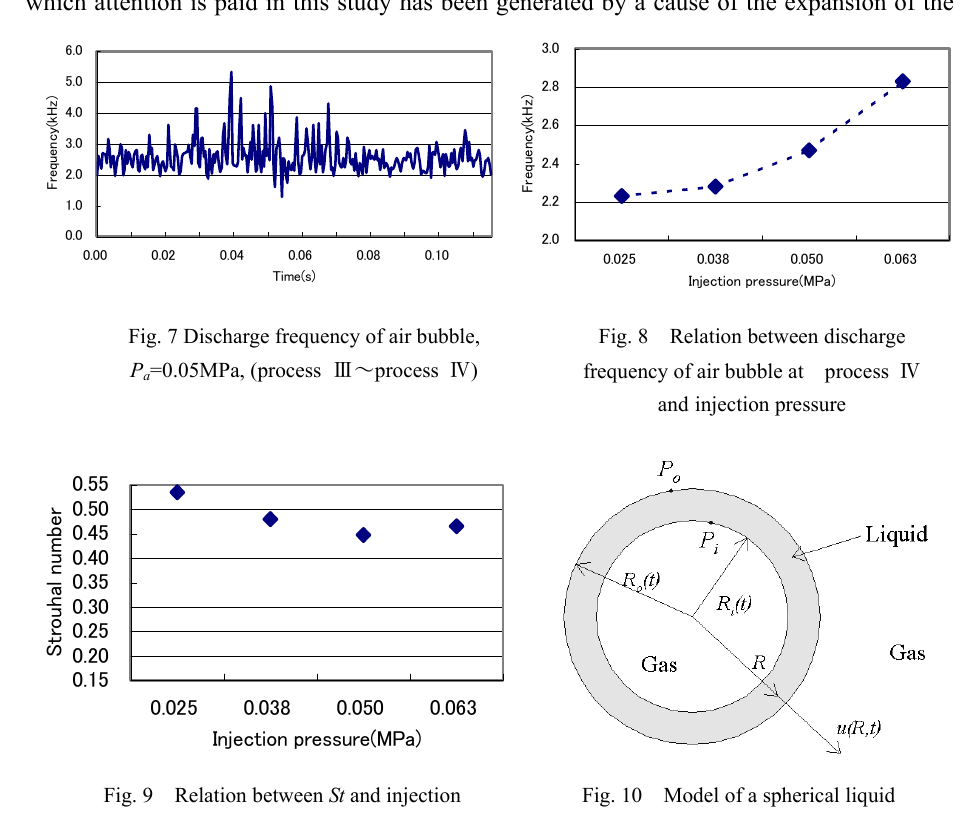
Fig. 10 Model of a spherical liquid membrane